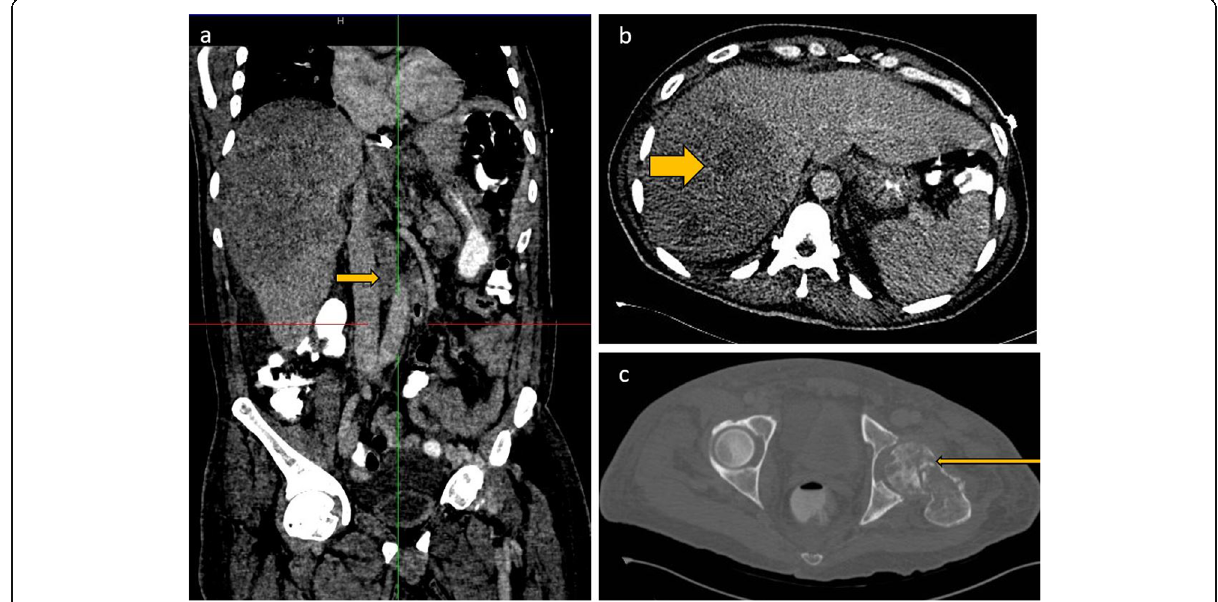
Fig. 4 Coronal and axial CECT images of the abdomen ( a and b ) show hepatomegaly and a heterogenous hypoattenuating mass infiltrating through most of the right lobe of the liver. The infiltrative liver mass had more focal hypoattenuating areas (fat arrow). Aortocaval lymph nodes are also noted (short arrow). Axial CT through the pelvis in bone window ( c ) shows a permeative process involving the left femoral head